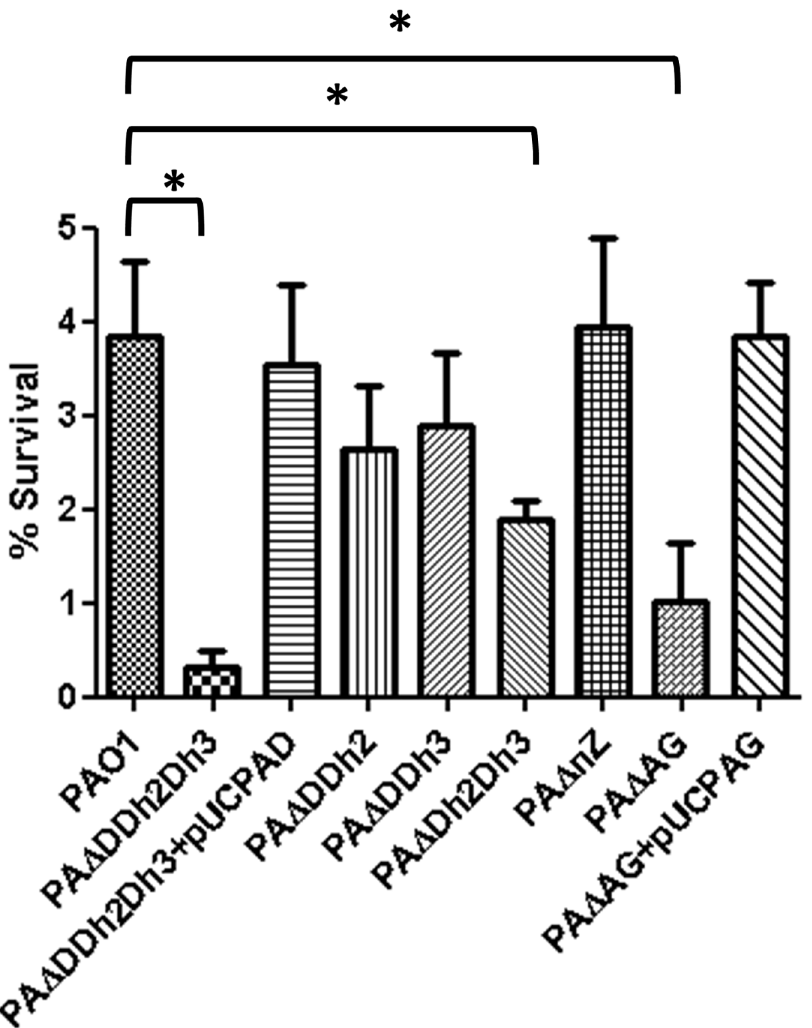
Fig 2. Bactericidal activity of lysozyme (25 μ g/mL) + colistin (0.1 μ g/mL) combined treatment in PAO1 and derived knockout mutants. The percentagesof bacterialsurvival after treatments respect to the initial inoculumare shown; The bars represent the mean of 5 experiments and the error bars the SD. * Statistically significant, P < 0.001 in the One-way ANOVA with post hoc Tukey’s multiplecomparisontest. PA Δ DDh2Dh3: knockout mutant on ampD , ampDh2 and ampDh3 genes; PA Δ nZ: knockoutmutant on nagZ ; PA Δ AG: knockout mutant on ampG . pUCPAD: pUC18-based Escherichia-Pseudomonas shuttle vector containing PAO1 AmpD gene. pUCPAG: pUC18-based Escherichia-Pseudomonas shuttle vector containing PAO1 AmpG gene.